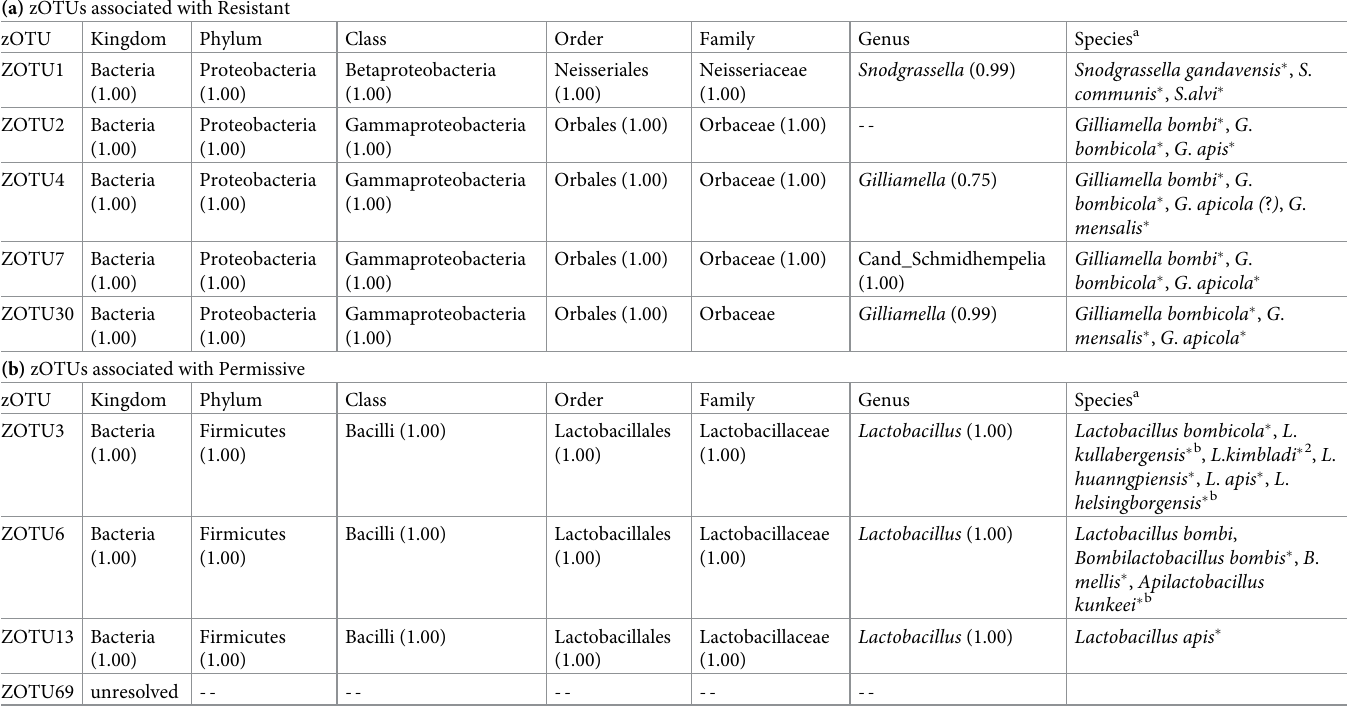
Table 6. Critical zOTUs in individual microbiotas of resistant and permissive groups.